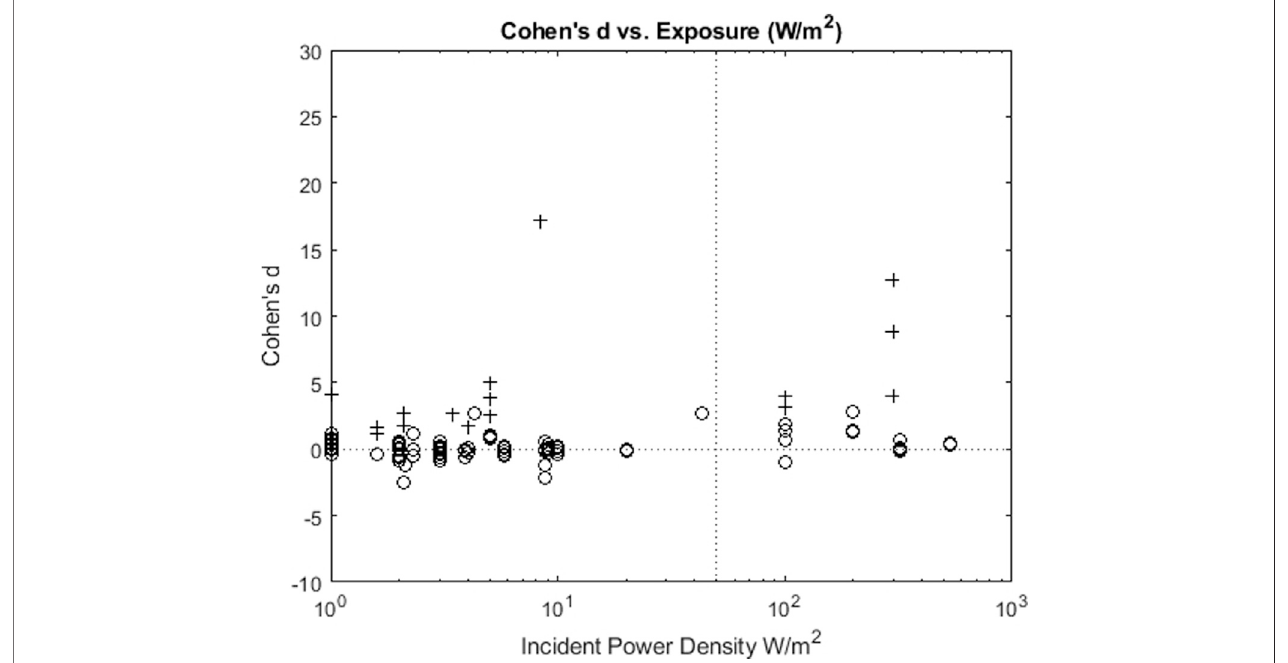
FIGURE 2 | Effect size (Cohen ’ s d) vs incident power density from 157 experiments in 31 studies. International Commission on Non-Ionizing Radiation Protection (ICNIRP), 2020 reference levels (occupational) shown by vertical dotted line. Experiments with statistically signi fi cant/not statistically signi fi cant increases in damage relative to controls are indicated by + and o respectively. For a list of endpoints see the Supplementary Material .